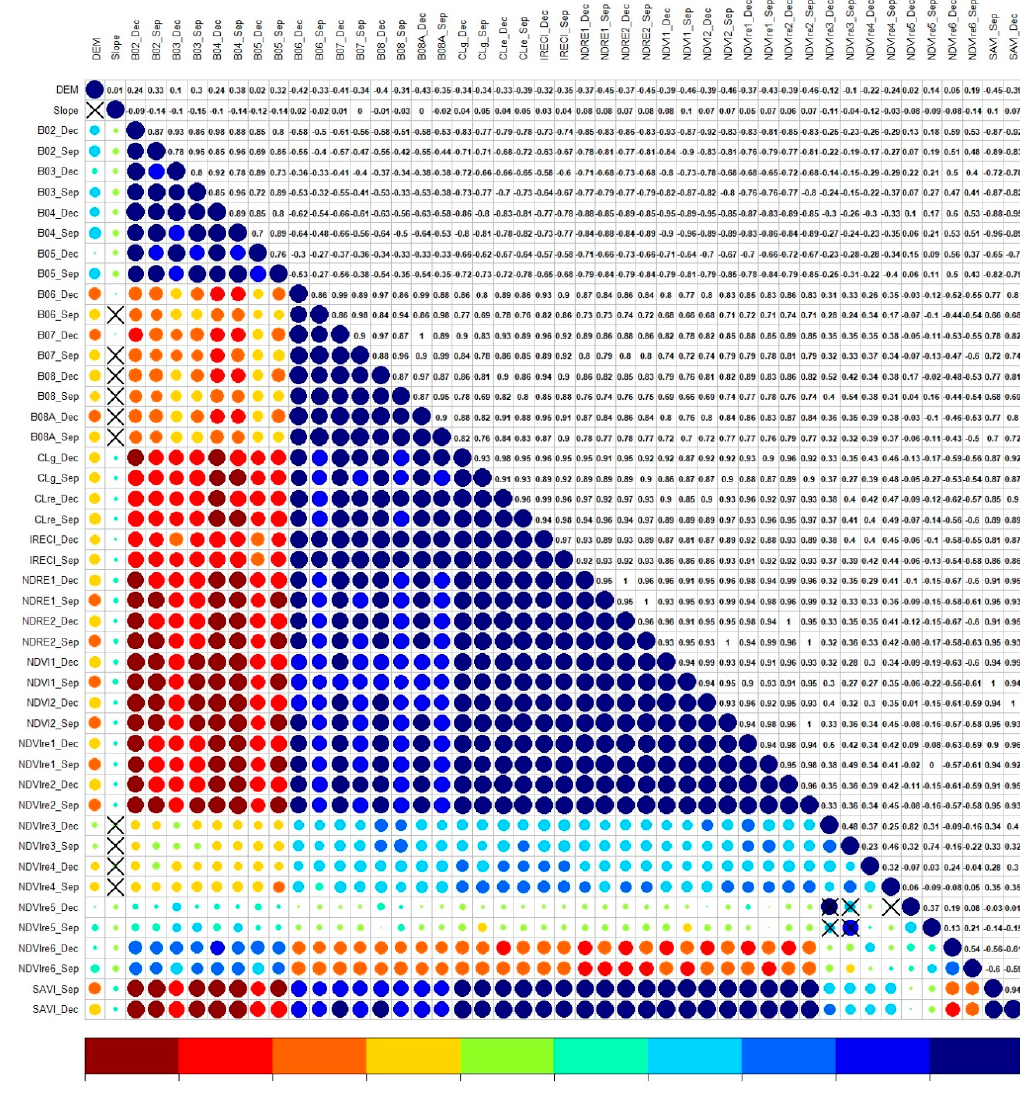
Figure 4. Pearson’s correlation among numerical covariates dataset, based on all samples (800) for the fifth taxonomic level. DEM = Elevation. Bands and indices assigned with a ‘Sep’ correspond to September images (dry season), while those assigned with a ‘Dec’ correspond to December images (wet season). B02 to B08A = Sentinel-2 MSI bands; CLg = Green chlorophyll index; CLre = Chlorophyll index; IRECI = Inverted Red-Edge Chlorophyll Index; NDRE 1 to 2 = Normalized Difference Red-edge; NDVI 1 to 2: Normalized difference vegetation index; NDVIre 1 to 6 = Normalized difference vegetation index red-edge; SAVI = Soil-adjusted vegetation index.